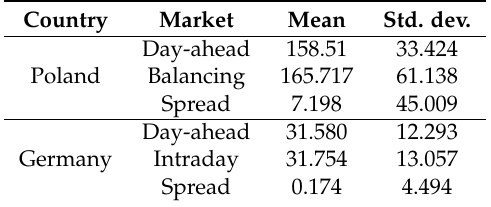
Table 2. Mean and standard deviation (Std. dev.) of the energy prices. Country